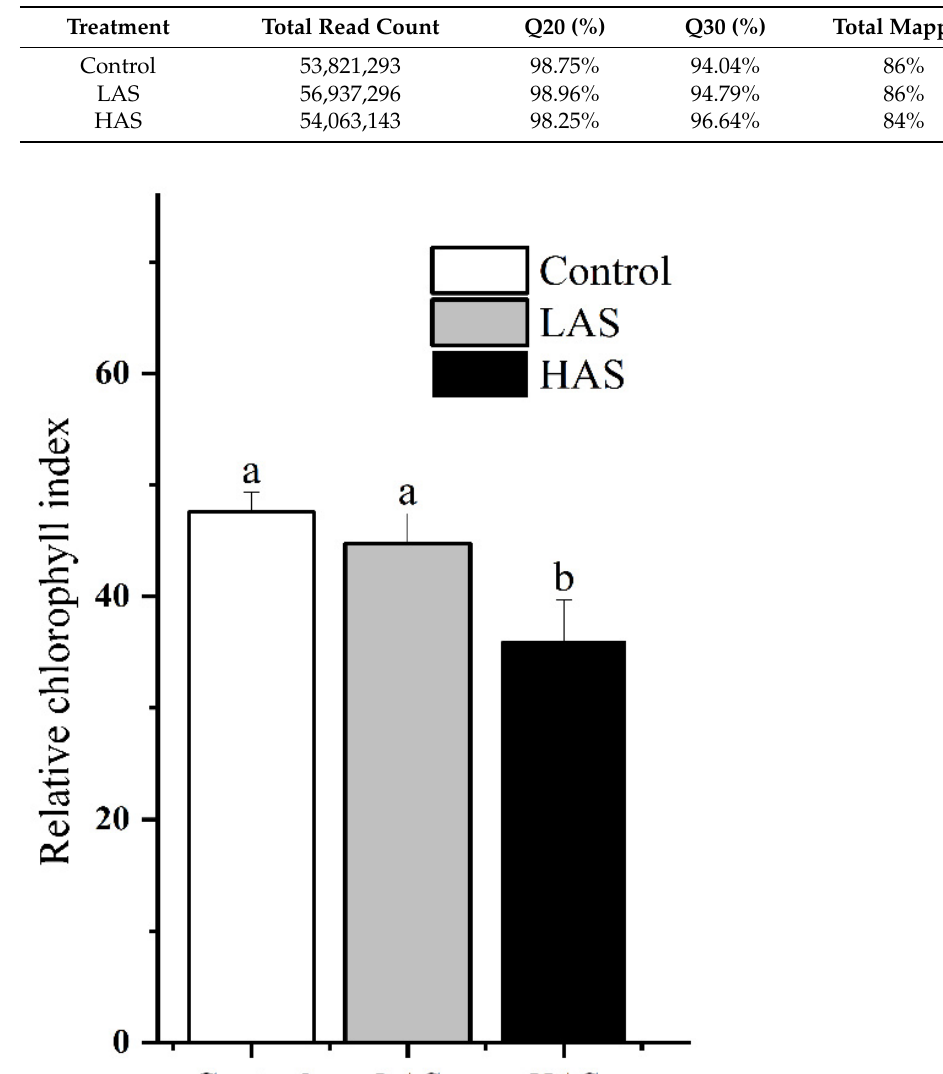
(92%) were downregulated after both LAS and HAS treatments. Thus, these DEGs with similar expression patterns may exhibit a more consistent response regulation pattern to alkaline stress. The number of upregulated genes in response to alkali stress was higher than that of downregulated genes, which is characteristic of the root system of M. cerifera . Notably, 9 and 6 DGEs that were upregulated and downregulated, respectively, after LAS treatment showed the opposite expression patterns after HAS treatment. This indicates that different regulatory mechanisms may have been induced for different alkali stress concentrations, but further verification is required. Table 1. Summary of read counts and total bases for various alkali stress groups in M. cerifera . Control, alkali stress control group; LAS, low-concentration alkali stress treatment group of M. cerifera ; HAS, high-concentration alkali stress treatment group of M. cerifera .